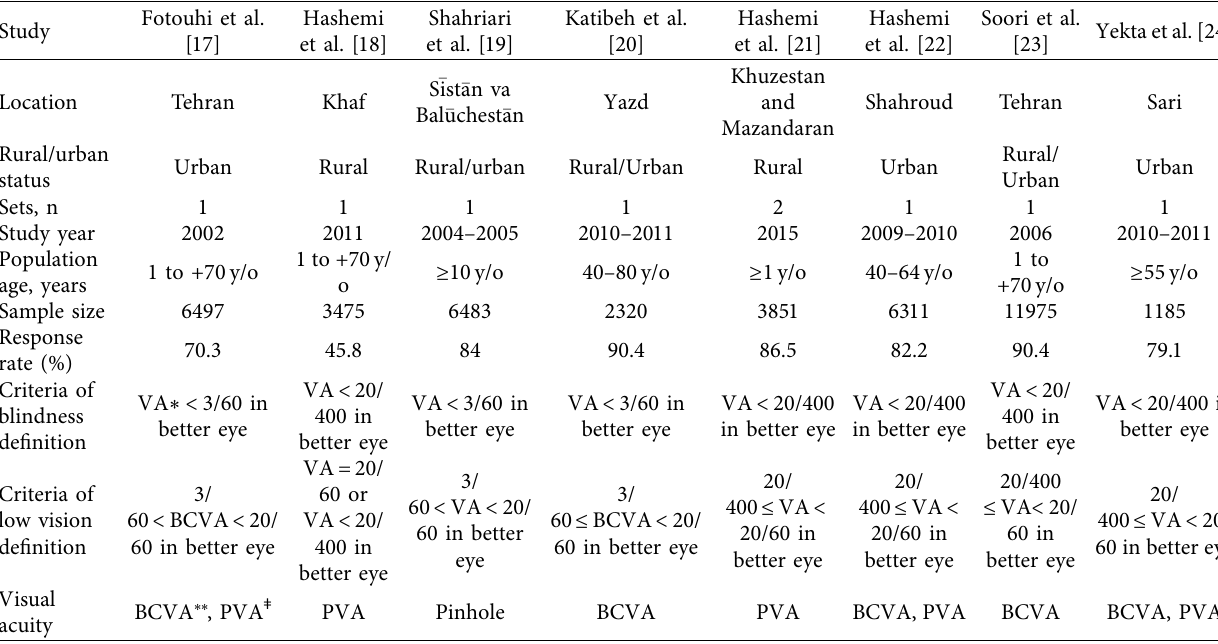
Figure 1: Flowchart of the process of study selection, which is based on MOOSE guideline. Table 1: Population-based studies reporting on the prevalence of blindness and low vision in Iranian